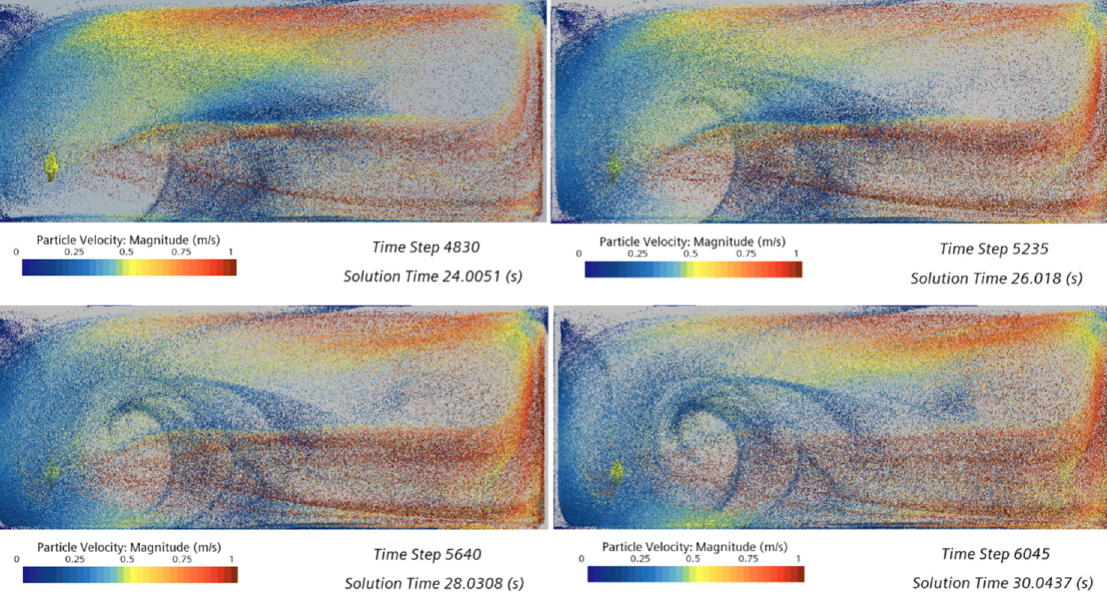
Figure 11. Reflux-mixing stage.